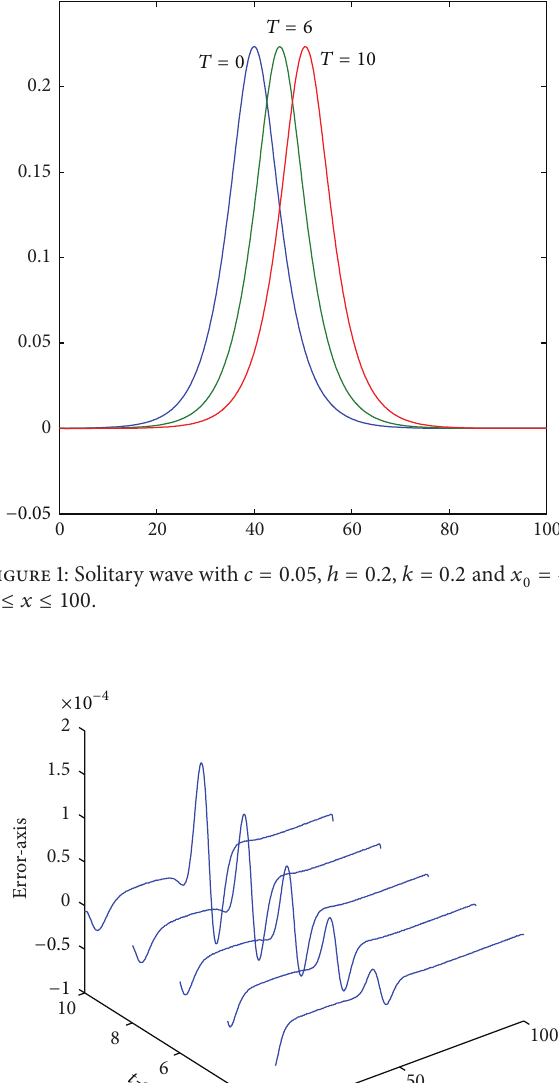
Figure4:Errorgraphfor 𝑐 = 0.3 , ℎ = 0.1 , 𝑘 = 0.01 and 𝑥 0 = 40, 0 ≤ 𝑥 ≤ 100